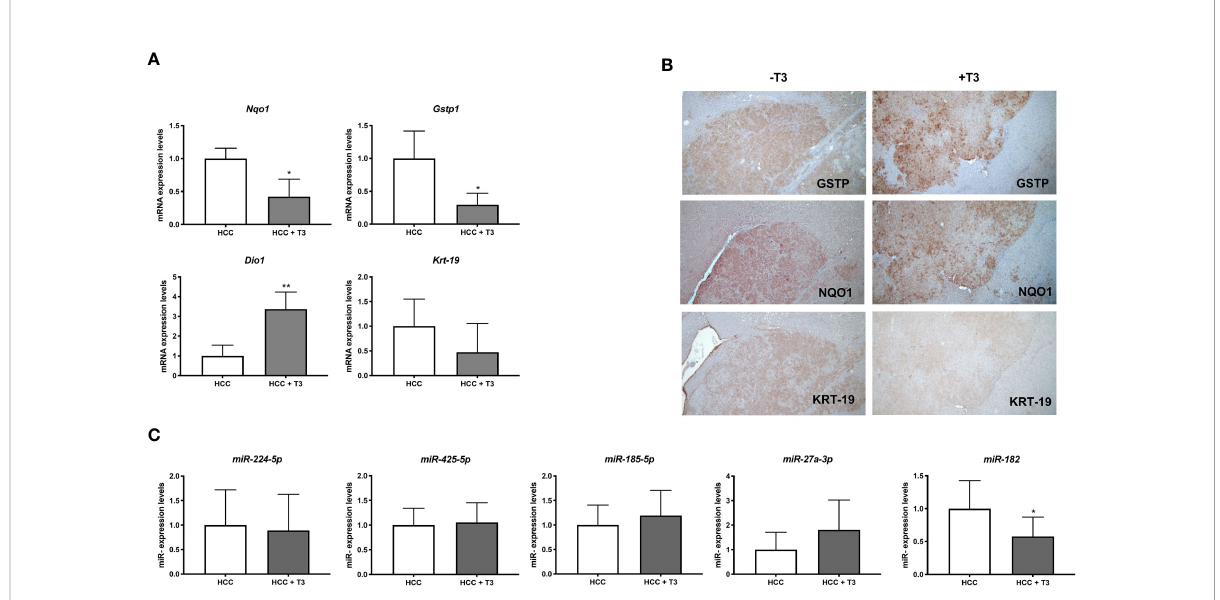
FIGURE 5 QRT-PCR analysis of miRs and mRNAs involved in T3/THR axis and Nrf2 pathway following T3 treatment in HCC. (A) qRT-PCR analysis of the expression of Gstp, Nqo1, Dio1 and Krt-19 in HCC bearing rats. Rats exposed to the R-H protocol were sacri fi ced 10 months after treatment with a single dose of DEN. The week prior to sacri fi ce, one group of animals was fed a T3-supplemented diet as described in Materials and Methods. Each sample was run in triplicate and gene expression analysis of beta-actin was used as endogenous control. Relative quanti fi cation analysis for each gene was calculated by 2 - DD Ct method. Student t-test: *P<0.05; **P<0.01; Values are expressed as mean ± SD; (B) GSTP, NQO1 and KRT-19 immunohistochemistry of HCCs from livers of animals treated as described in B (X5); (C) qRT-PCR analysis of the expression of miR-224, miR-425-5p, miR-185, miR-182, and miR-27 in HCC bearing rats. Each sample was run in triplicate and U6 snRNA was used as endogenous control. Relative quanti fi cation analysis for each gene was calculated by 2 - DD Ct method. Student t-test: *P<0.05. Values are expressed as mean ±